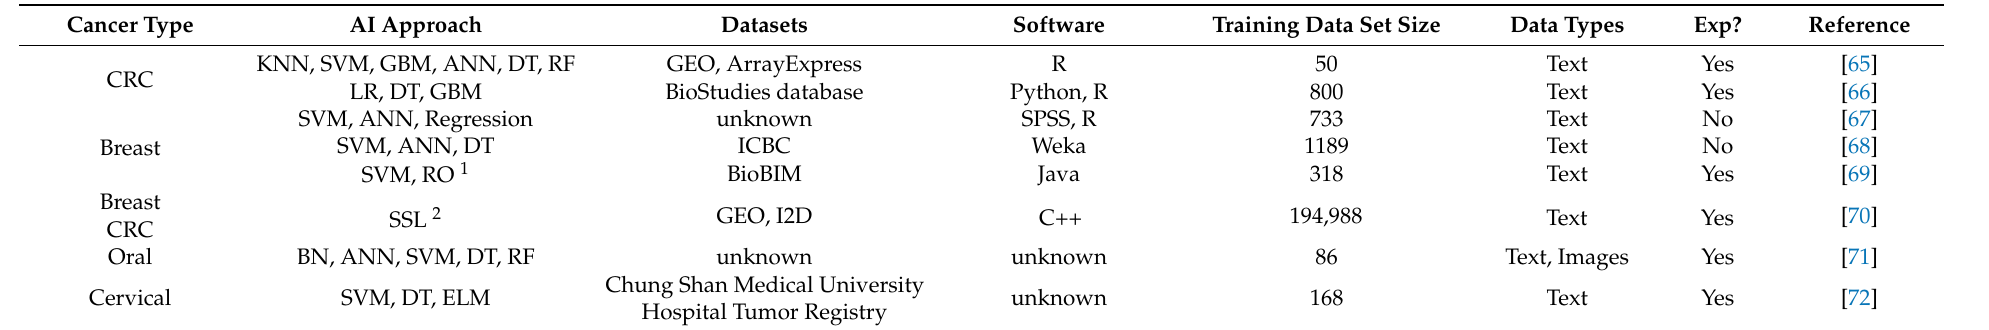
Table 2. Summary of studies analysed in Section 3.2 about cancer recurrence.